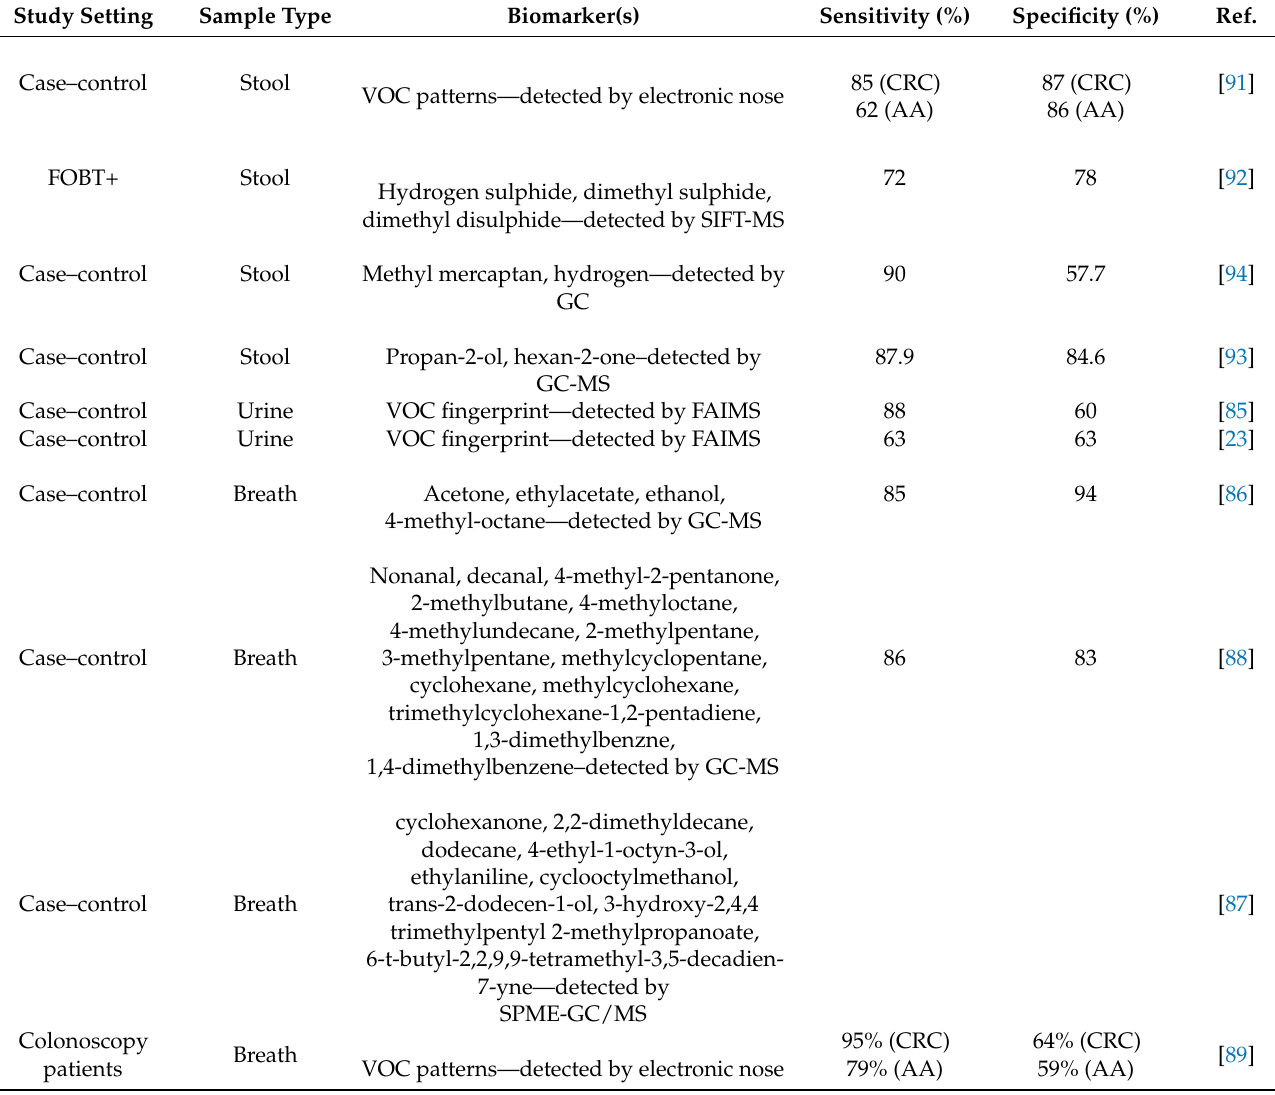
Table 3. Volatile organic compounds (VOCs) used for CRC and advanced adenoma